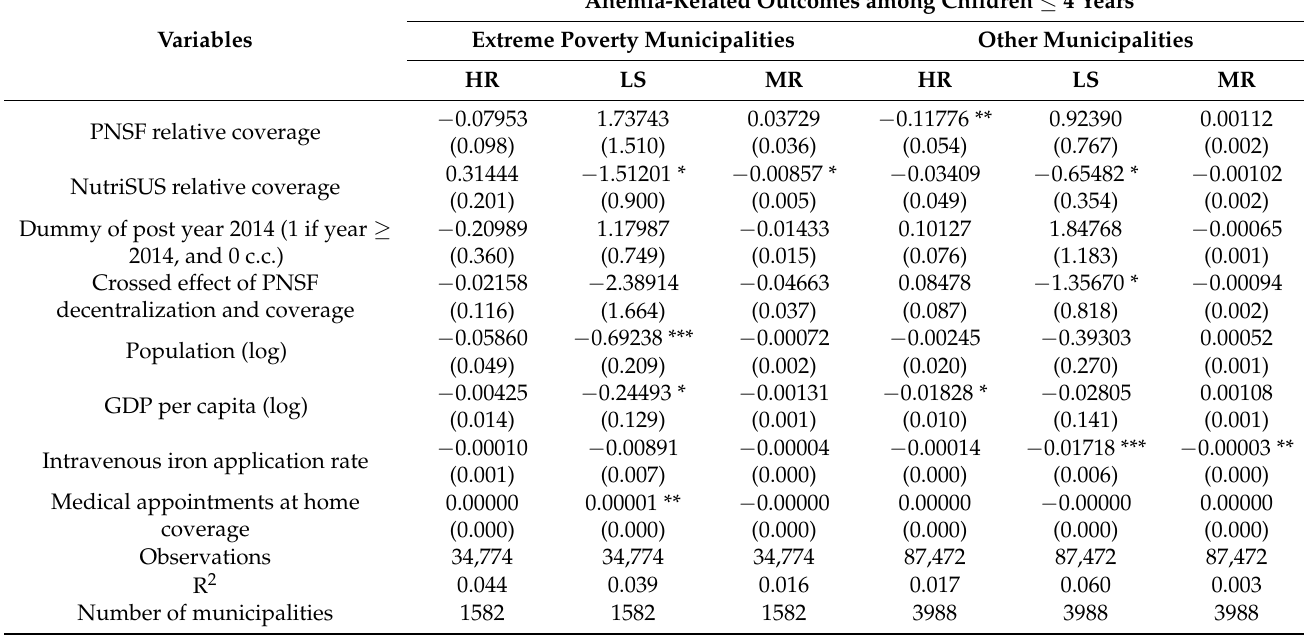
Table 5. Coefficients of the DD–FE estimates on the effects of the PNSF and NutriSUS on anemia-related outcomes among children, according to poverty categorization, Brazil,